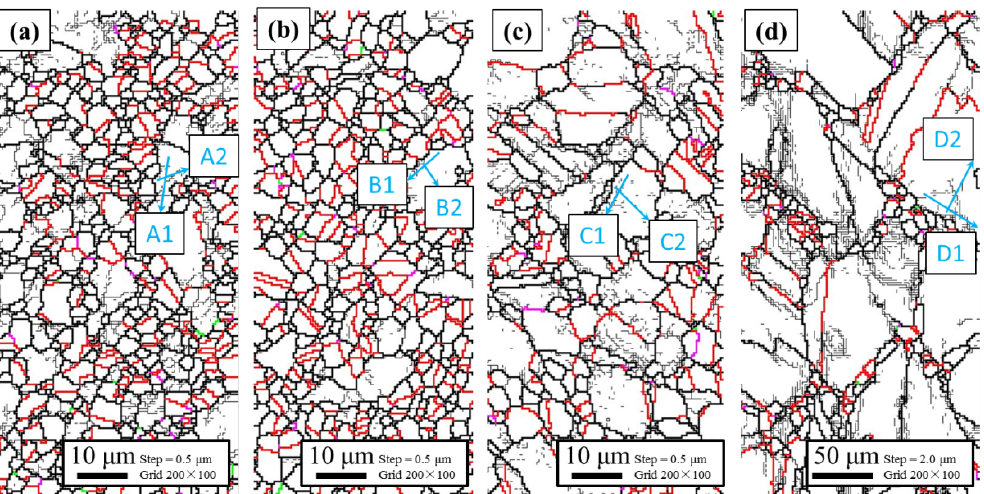
Figure 7. Grain boundary maps of the specimens deformed to a 0.4 effective strain with different temperatures (Thin black lines represent the low angle grain boundary; thick black lines represent the high angle grain boundary; red, pink, green lines represent Σ 3, Σ 9, Σ 27, twin boundaries respectively, A1, A2, B1, B2, C1, C2, D1, D2 were marked to analyses the misorientation within grains in Section 3.4.5.): ( a ) 960 ° C, ( b ) 990 ° C, ( c ) 1010 ° C, ( d ) 1040 ° C.